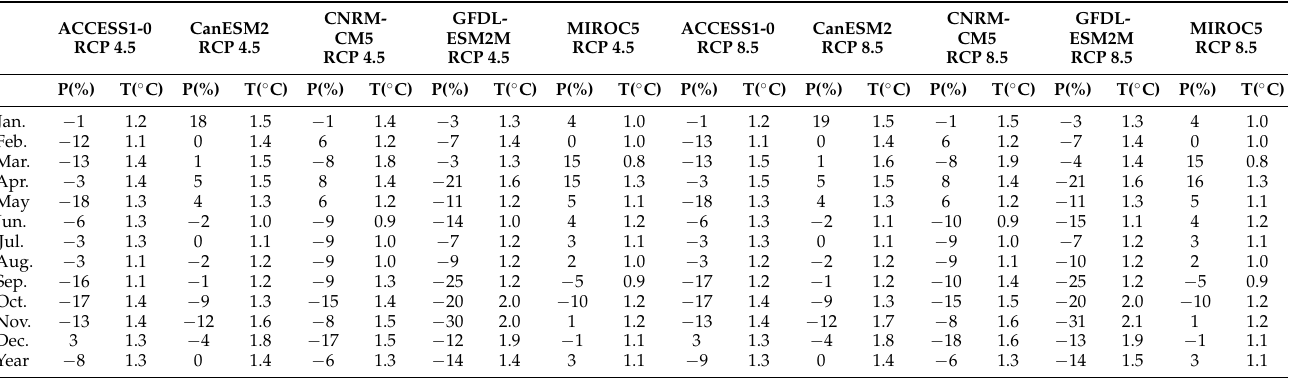
Table 3. Change of rainfall (P, %) and temperature (T, ◦ C) as projected by the climate models under different scenarios in 2030.